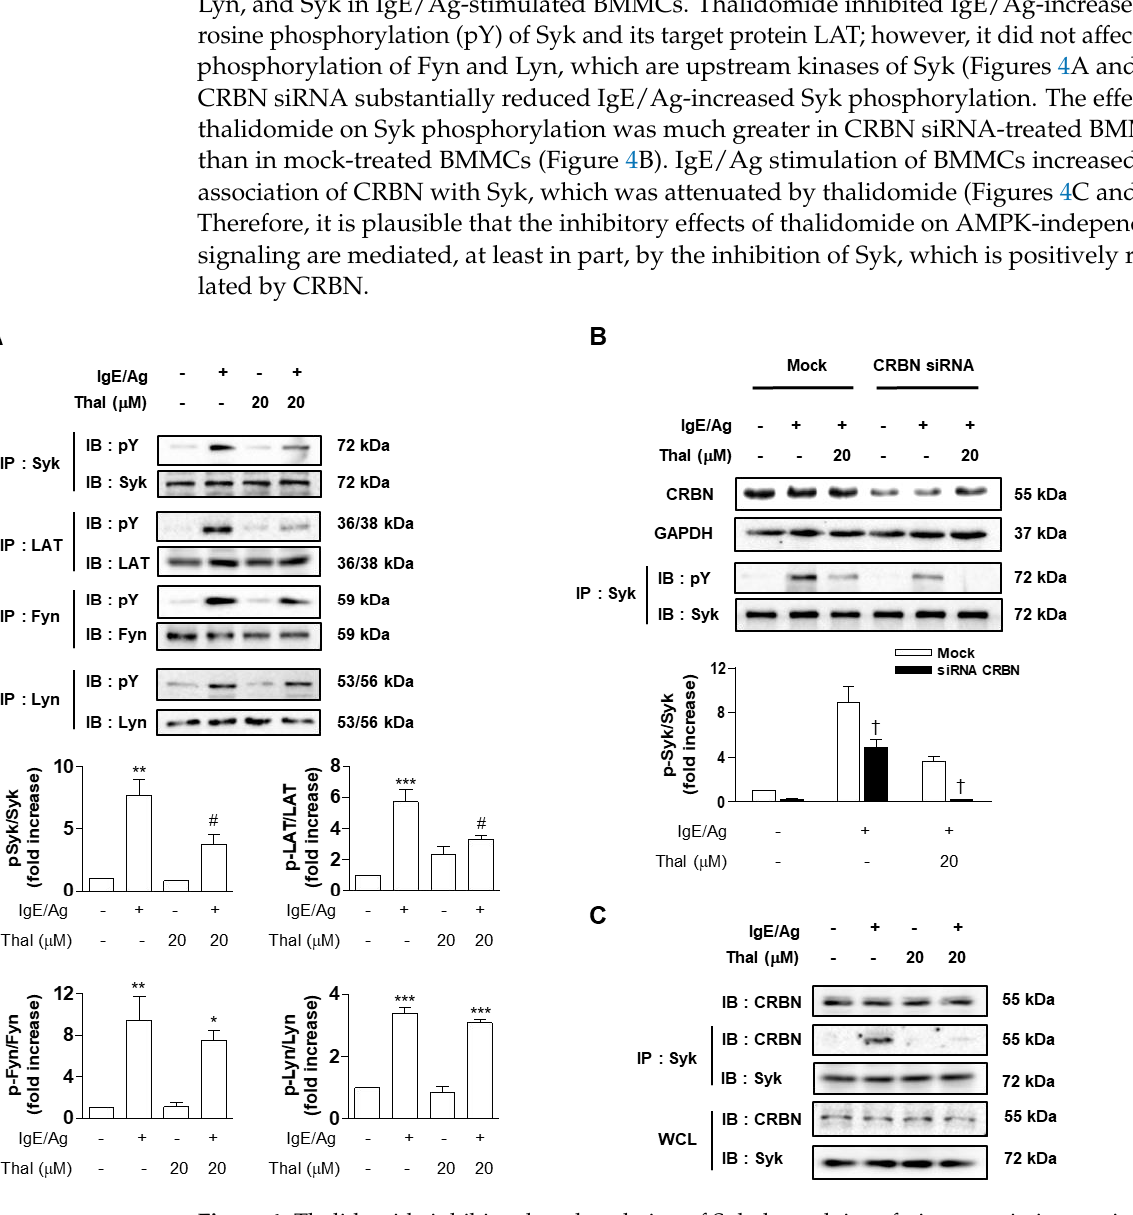
Figure 4. Thalidomide inhibits phosphorylation of Syk through interfering protein interactions of Syk with CRBN in IgE/Ag-stimulated BMMCs. BMMCs were sensitized with anti-DNP IgE and treated with thalidomide (Thal) for 1 h ( A , C ) or IgE-sensitized BMMCs were transfected with CRBN siRNA or non-specific (Mock) siRNA for 48 h and then treated with Thal ( B ), followed by stimulation with DNP-HSA (Ag) for 15 min. The immunoprecipitates or whole cell lysates (WCL) were subjected to immunoblot analysis with indicated antibodies. The immunoblot data are representative of three independent experiments. The bar graph presents the ratio of band intensity of phosphorylated signaling molecules to those of the total proteins ( A , B ). Data indicate the means ± SEM (n = 3, * p < 0.05, ** p < 0.01 and *** p < 0.001 vs. control; # p < 0.05 vs. IgE/Ag alone; † p < 0.05 vs. Mock in each